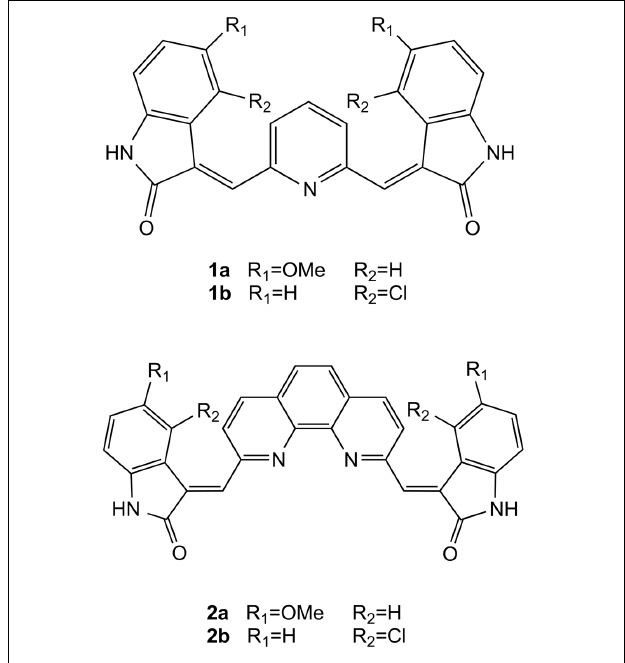
FIGURE 1 | Chemical structures. Chemical structures of compounds 1a,b and 2a,b .